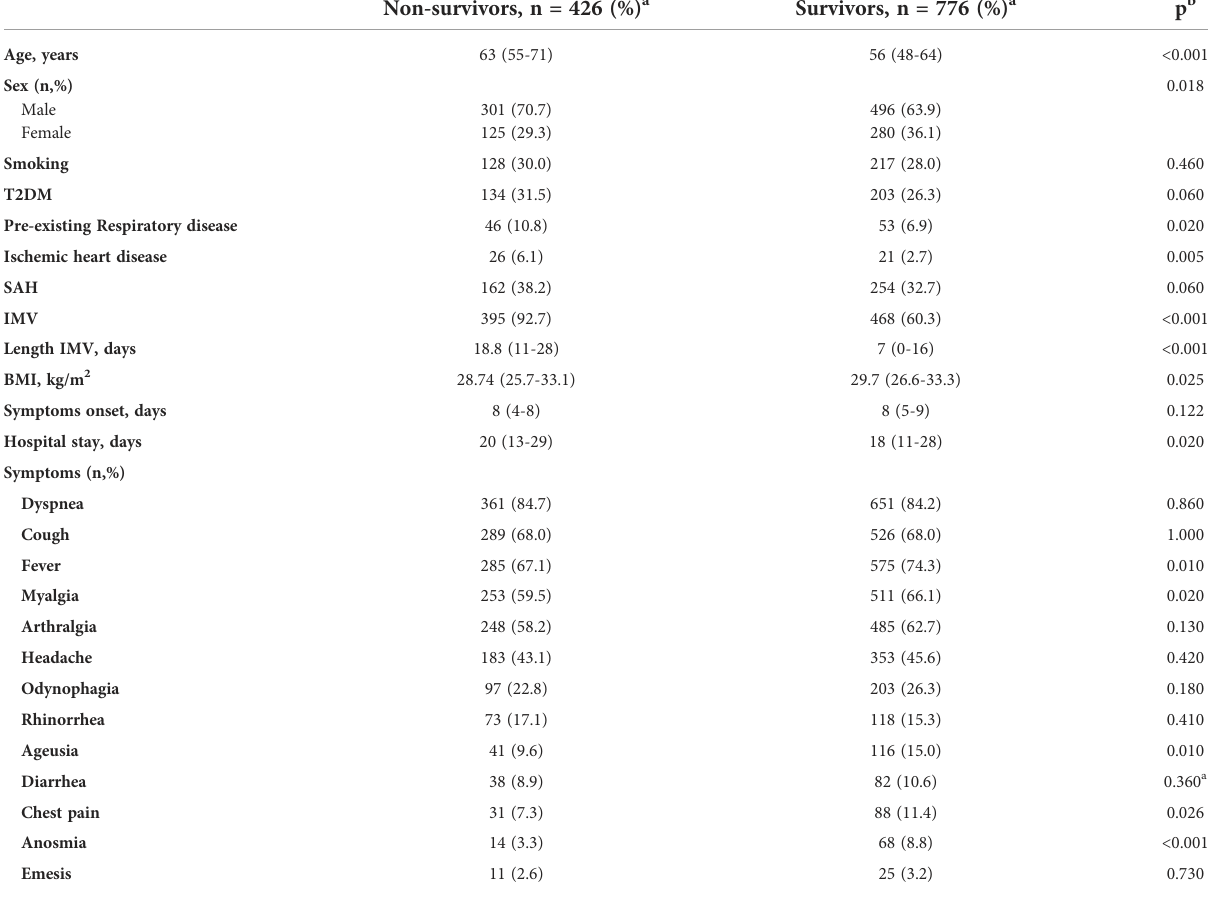
TABLE 1 Demographic and clinical data of patients with severe